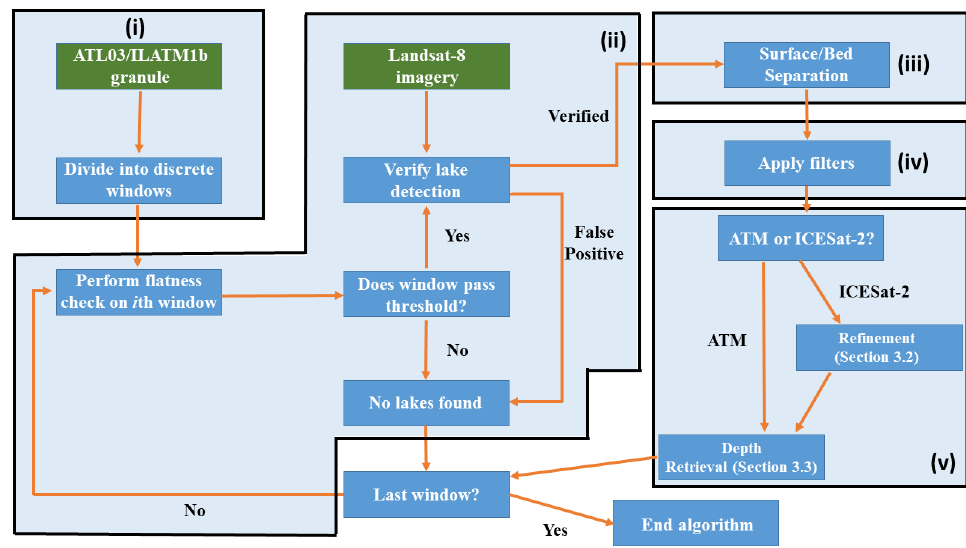
Figure 1. Schematic for the workflow of the lake surface–bed separation algorithm.